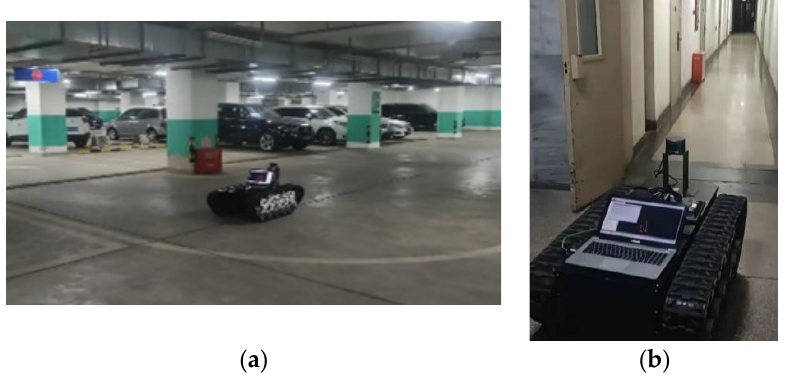
Figure 7. Experimental scene and experimental platform: ( a ) Scene 1: the underground parking lot; and ( b ) Scene 2: the building corridor with looped structure.